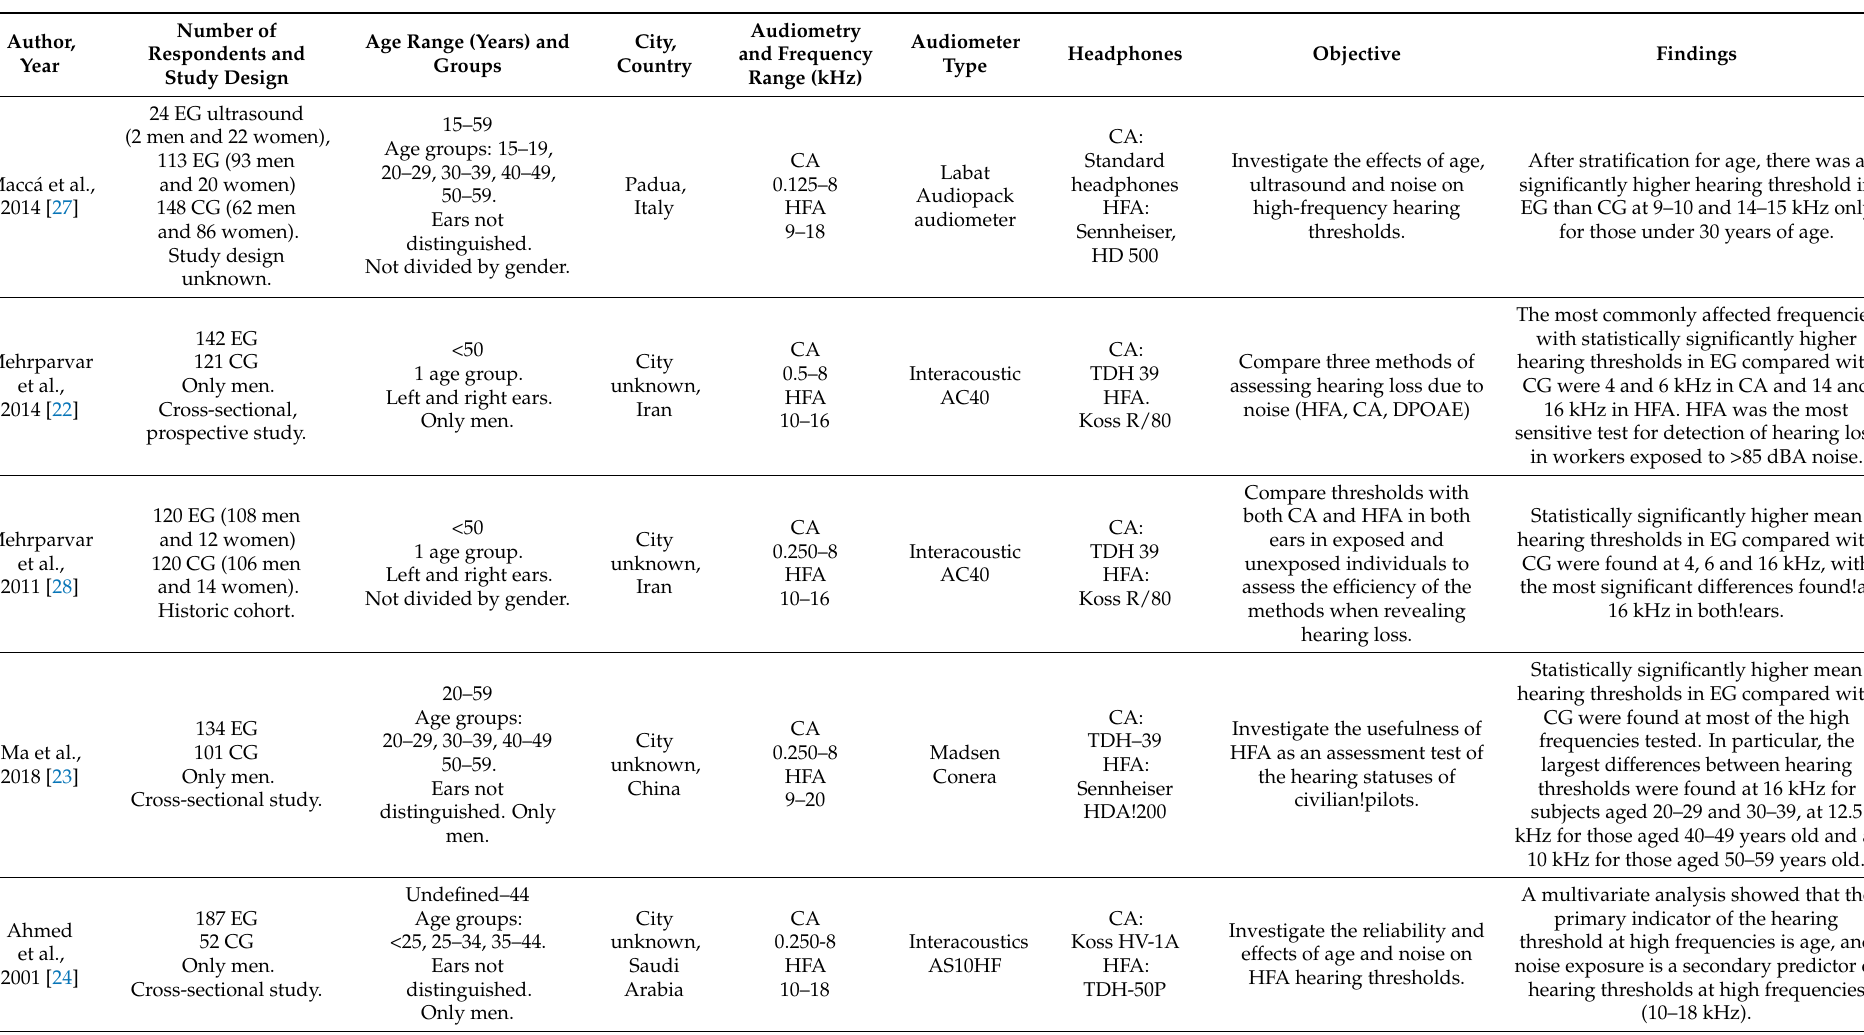
Table 2. Overview of the selected articles on hearing loss and high-frequency audiometry in populations exposed to workplace